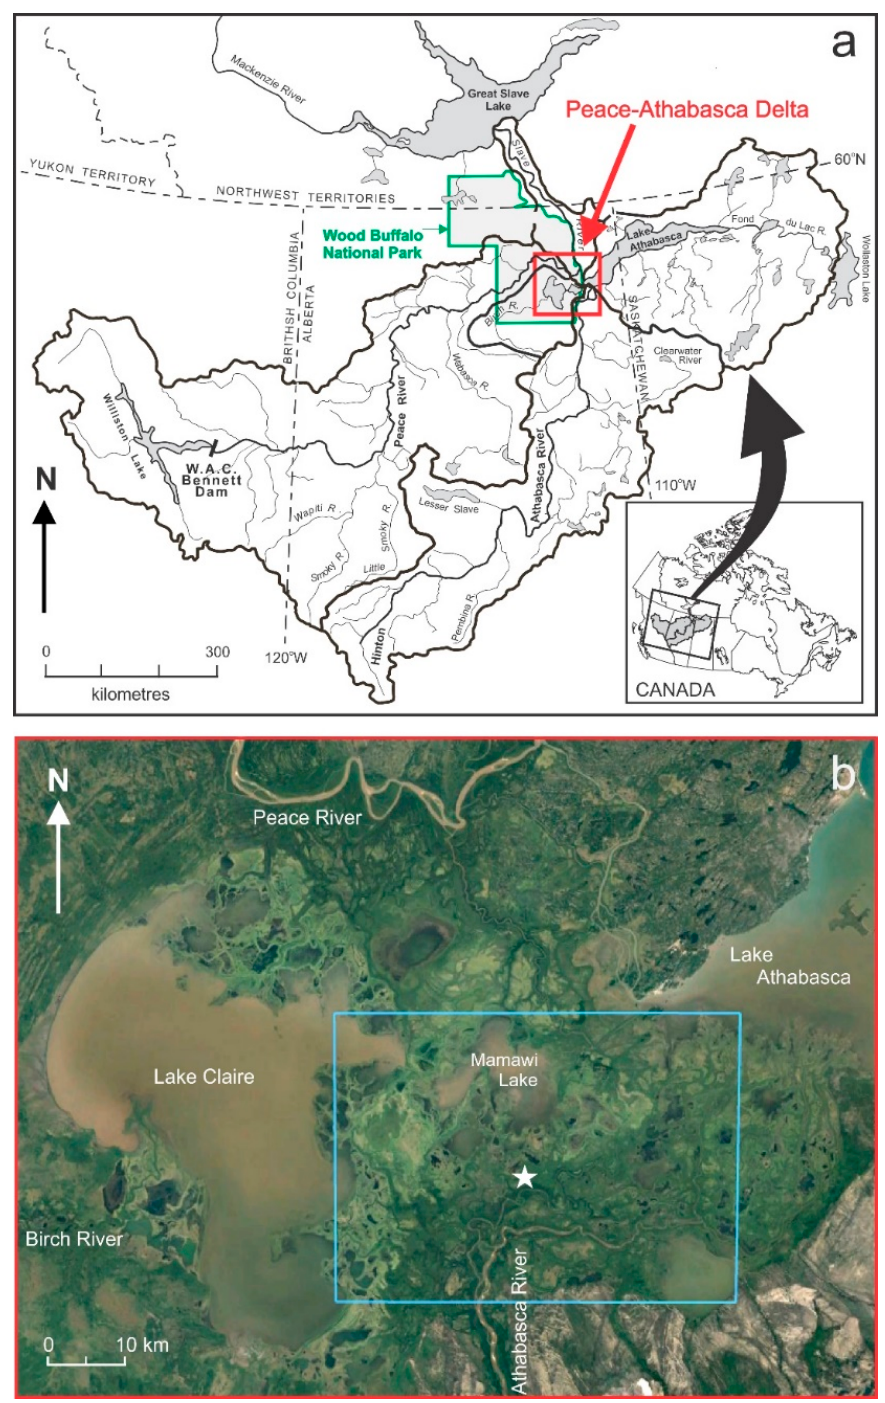
Figure 1. ( a ) Location of the Peace–Athabasca Delta (PAD) within western Canada (red rectangle) and ( b ) GoogleEarth satellite basemap of the PAD. The star indicates the location of the picture shown in Figure 2 and the blue polygon is the area shown in Figure 3.